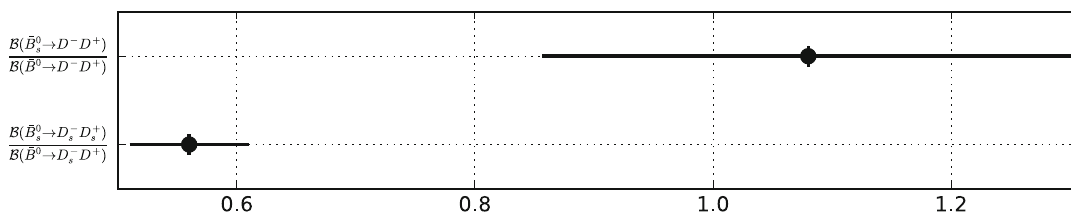
Fig. 159 Summary of the averages from Table 193